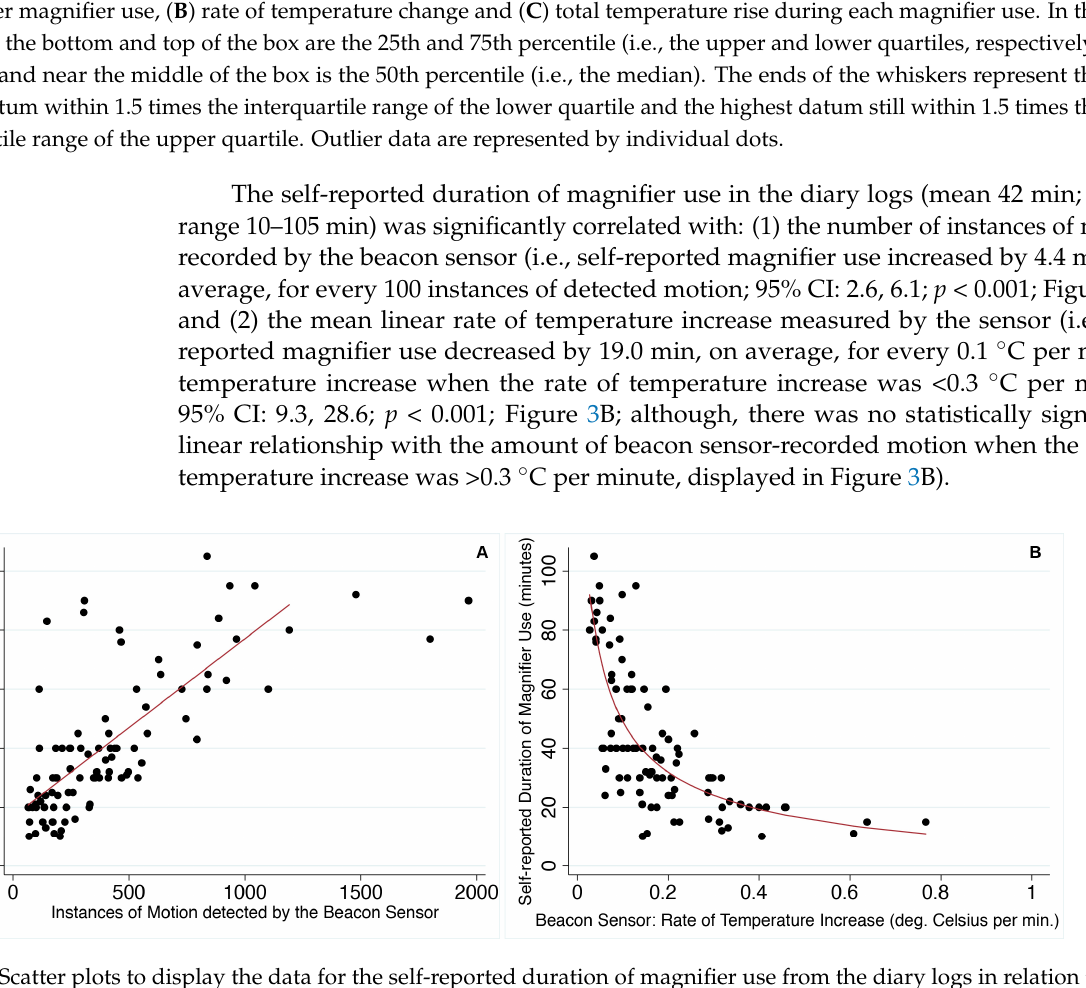
Figure 3. Scatter plots to display the data for the self-reported duration of magnifier use from the diary logs in relation to data recorded by the beacon sensor during the period of magnifier use for: ( A ) the number of instances of detected motion, and ( B ) the mean rate of temperature rise. ( A ) The linear fitted line excludes three outlier data points with greater than 1300 instances of motion. ( B ) The fitted line is a curve for the predicted fractional polynomial.